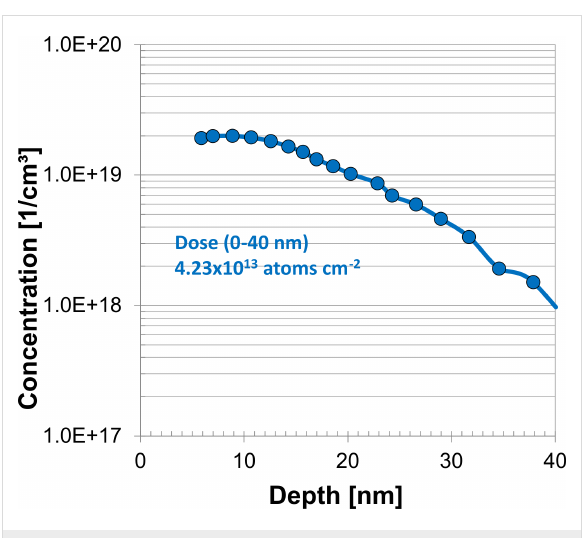
Figure 4: ECV plot of active carrier concentrations in a 66 nm SOI after MLD using a 50 nm sputtered SiO 2 cap and annealing at 1050 °C for 5